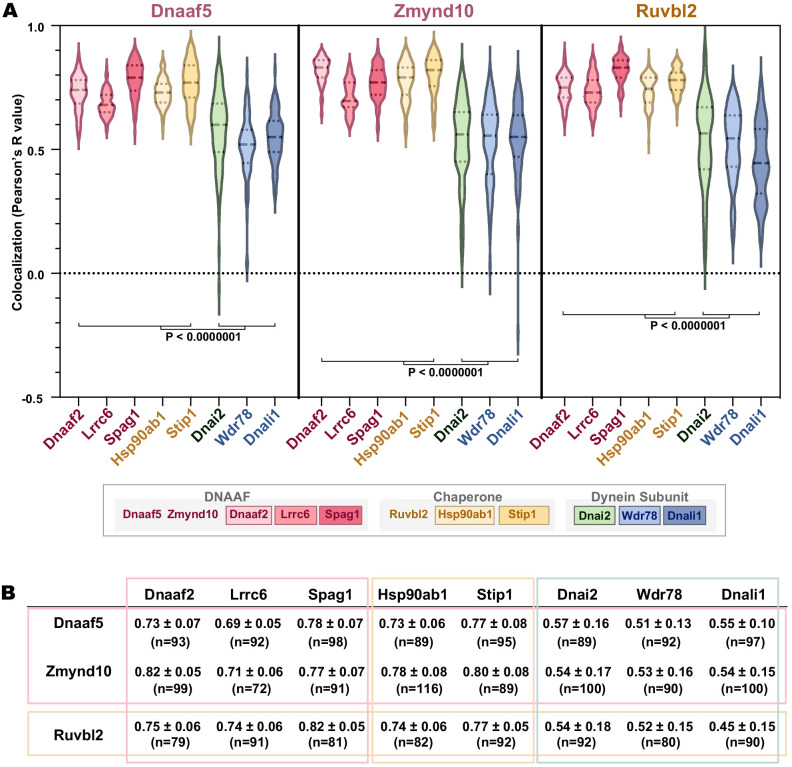
Quantification of localization data.(A) Graph displaying Pearson correlation for colocalizations between DNAAF, chaperone or dynein subunits. Dnaaf5, Zmynd10 and Ruvbl2 were tagged with mCherry. GFP fusion proteins are Dnaaf2, Lrrc6, Spag1, Hsp90ab1, Stip1, Dnai2, Wdr78 and Dnali1. p-value<0.0000001 by one-way ANOVA and post-hoc Tukey-Kramer HSD test. (B) Table showing Pearson’s R values (Average ± STDEV) and n-value for each colocalization analysis (at least 15 cells from five embryos for each analysis).